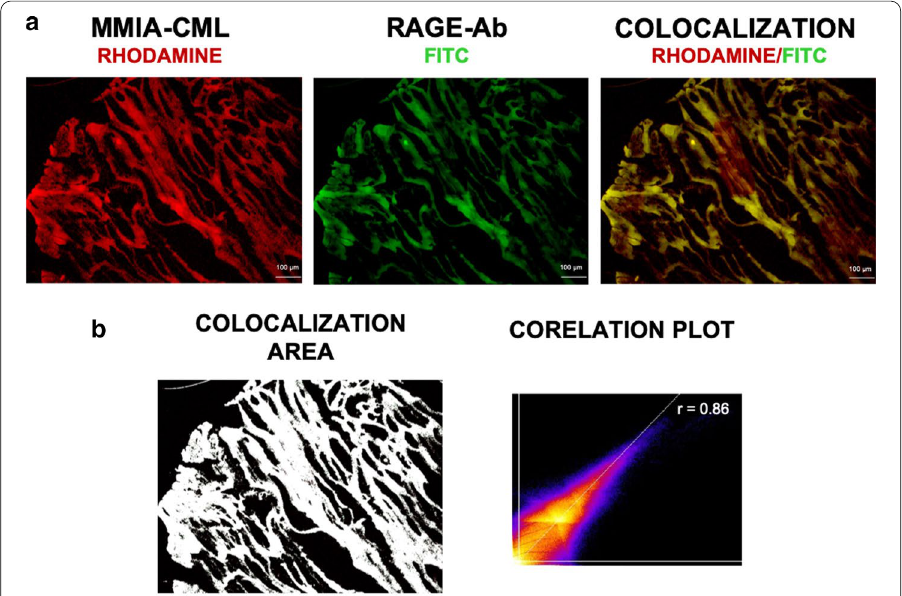
Fig. 5 Ex vivo tissue colocalization studies using fluorescence microscopy. Muscle tissue sections from mouse ischemic hindlimbs at one week after HLi were incubated with 1 µM RAGE-targeted nanoparticles and RAGE antibody conjugated with FITC ( a ). Studies demonstrated a significant degree of RAGE-targeted probe and antibody colocalization. Images were analyzed using ImageJ’s Coloc2 plugin and Pearson’s r value was calculated ( b